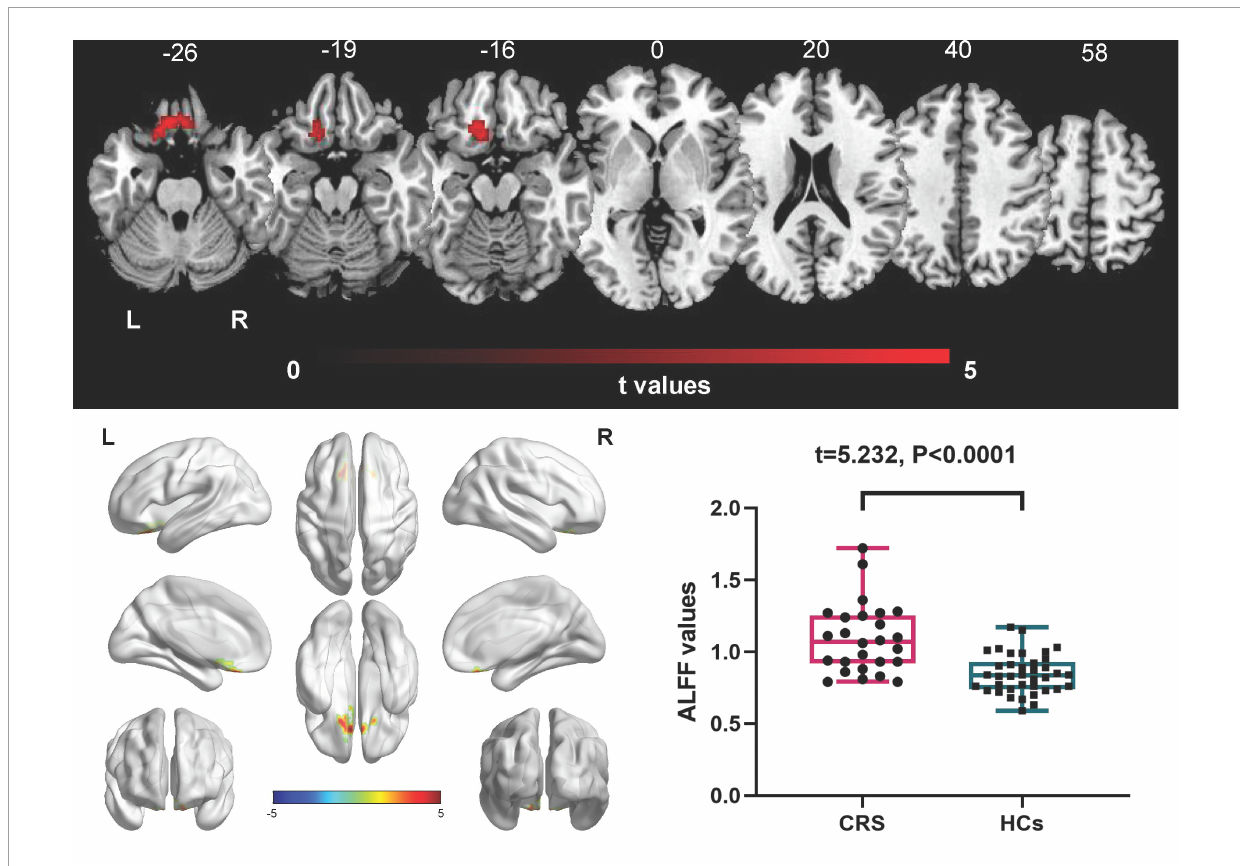
FIGURE1 Amplitude of low-frequency fluctuations (ALFF) differences between CRS patients and HCs ( P < 0.05, FDR corrected). Compared with HCs, patients with CRS showed significantly increased ALFF in the left orbital superior frontal cortex, extending to the left rectus. L, left; R, right.